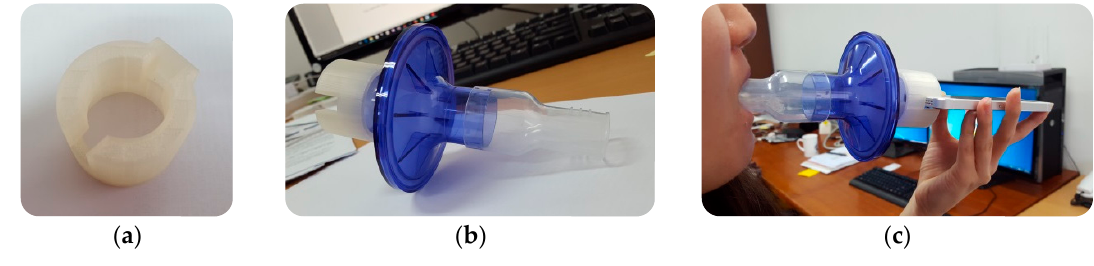
Figure 2. Audio data acquisition setup: ( a ) 3D-printing mouthpiece-to-iPhone adapter; ( b ) mouthpiece equipped with adapter; and ( c ) complete set of experimental and data acquisition equipment.